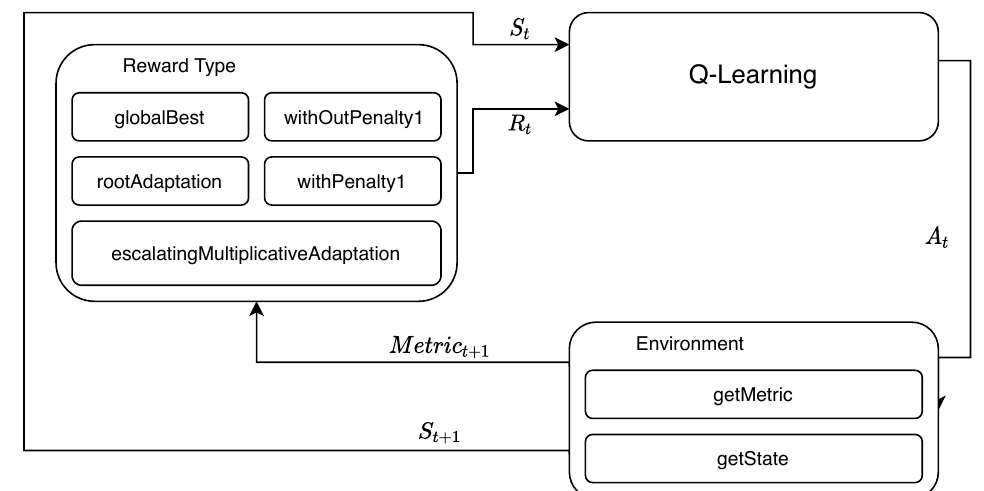
Figure 4. Q-Learning scheme for different